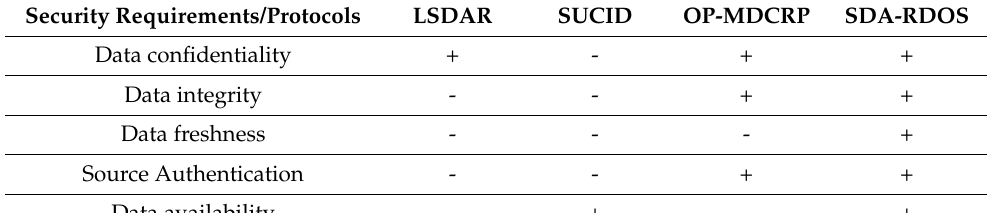
Figure 19. Packet delivery ratio (PDR) Analysis of LSDAR, SUCID, OOP ‐ MDCRP, and SDA ‐ RDOS protocols. Table 6. Security Analysis of LSDAR, SUCID, OOP-MDCRP, and SDA-RDOS protocols.